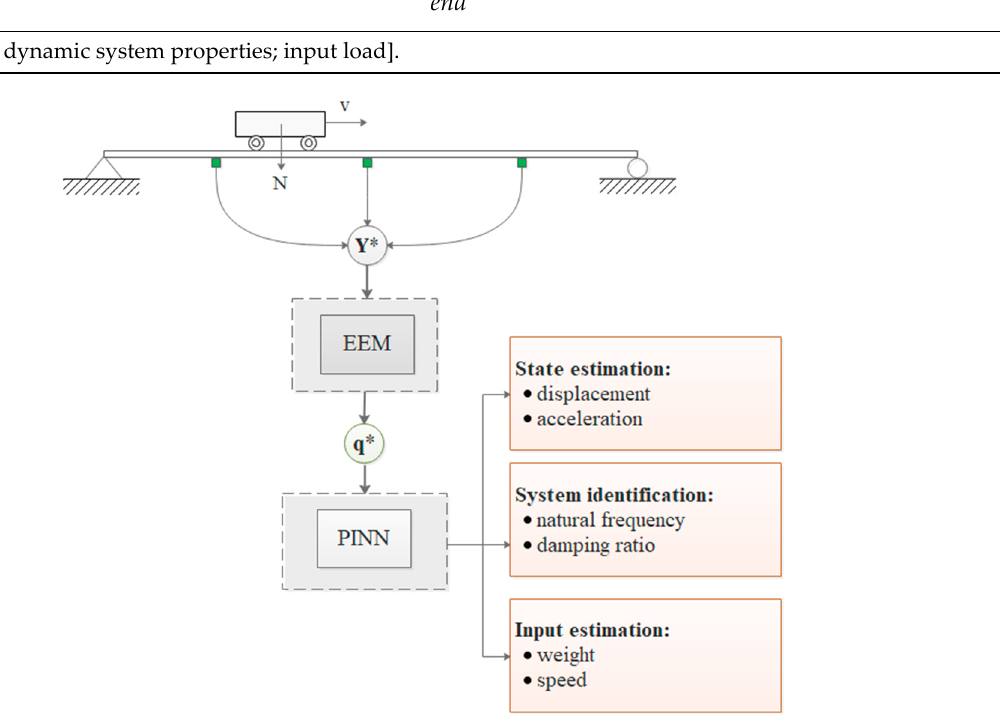
Figure 4. Input and outputs of a PINN framework for a beam subjected to moving load. Algorithm 1 Proposed framewoark with sequential and parallel PINNs.